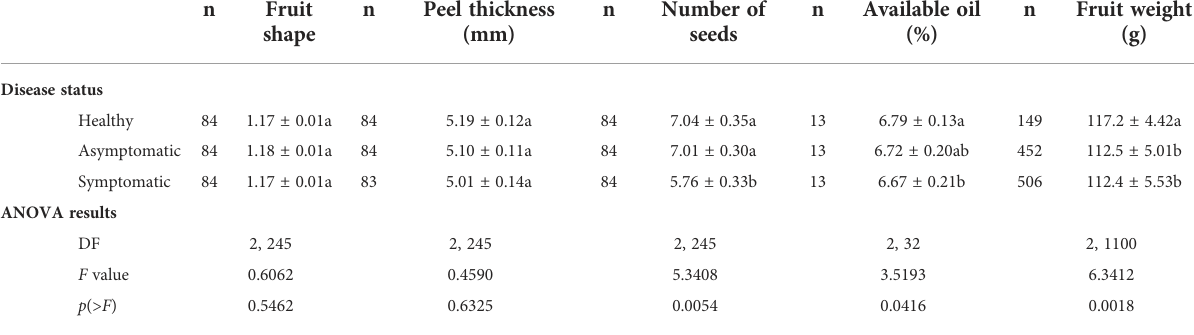
TABLE 4 Physical characterization of ‘ Femminello ’ lemon fruits from healthy trees and from the asymptomatic and symptomatic sector of HLB- affected trees (diseased trees) collected in different harvesting seasons in southeastern São Paulo State yz . n Fruit shape